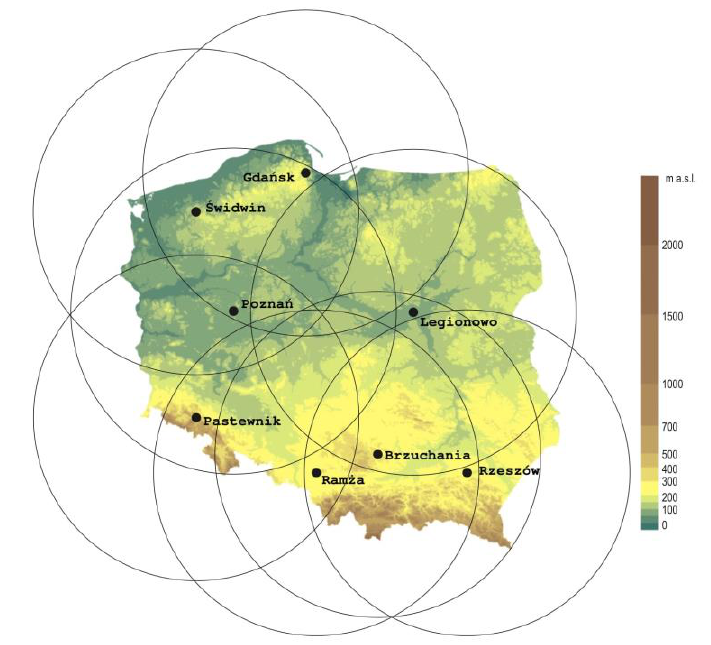
Fig. 1. Polish radar network - POLRAD. black dots – location of the radars. black circles - 250 km radar